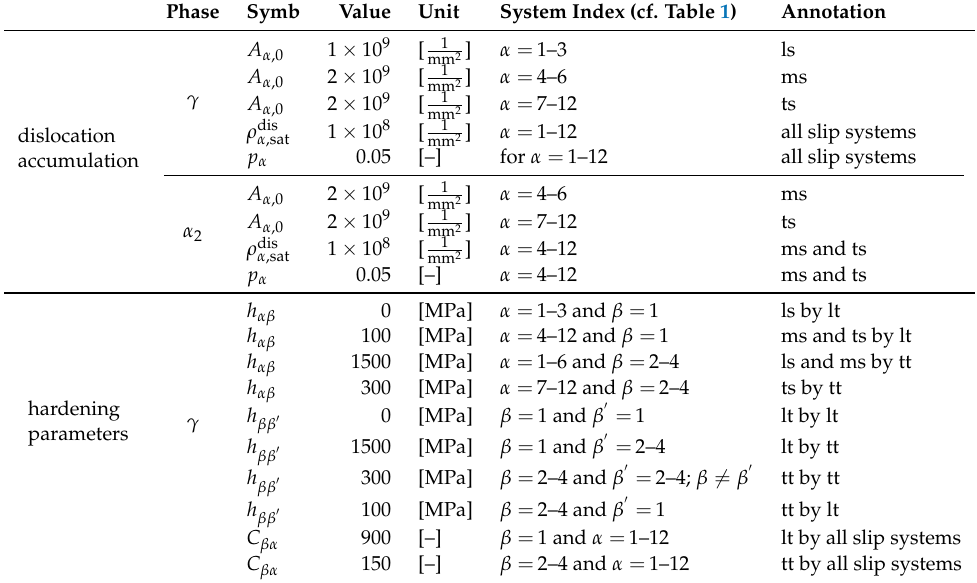
Table 3. Identified model parameters; ls: longitudinal slip, ms: mixed slip, ts: transversal slip, lt: longitudinal twinning, tt: transversal